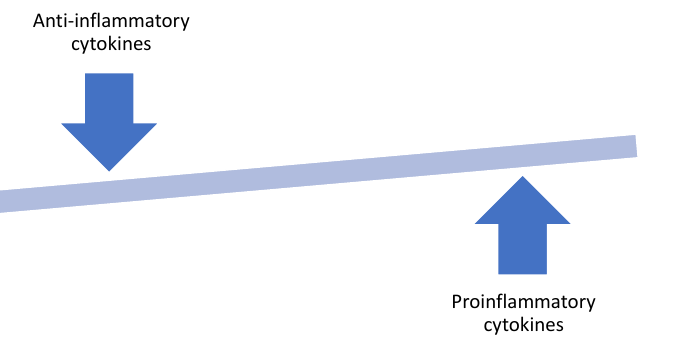
Figure 2. The hallmark of obesity is a shift in the adipose tissue homeostasis that favors the production of pro-inflammatory cytokines